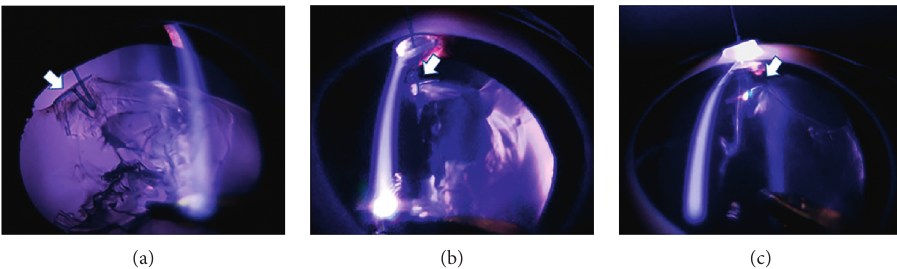
Figure 3: One CE was inserted from the opposite side of the main port (arrow). In the CE group, although the lens equator was stretched, the position of the capsular bag was shifted upward (arrow, a–c, n � 3).